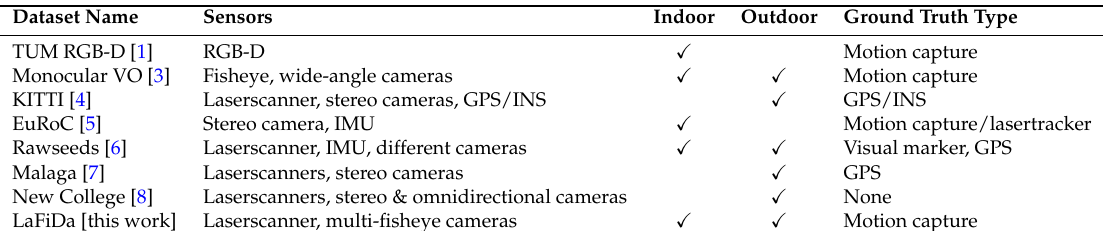
Table 1. Overview of related datasets. GPS: Global Positioning System; INS: Inertial Navigation System; IMU: Inertial Measurement